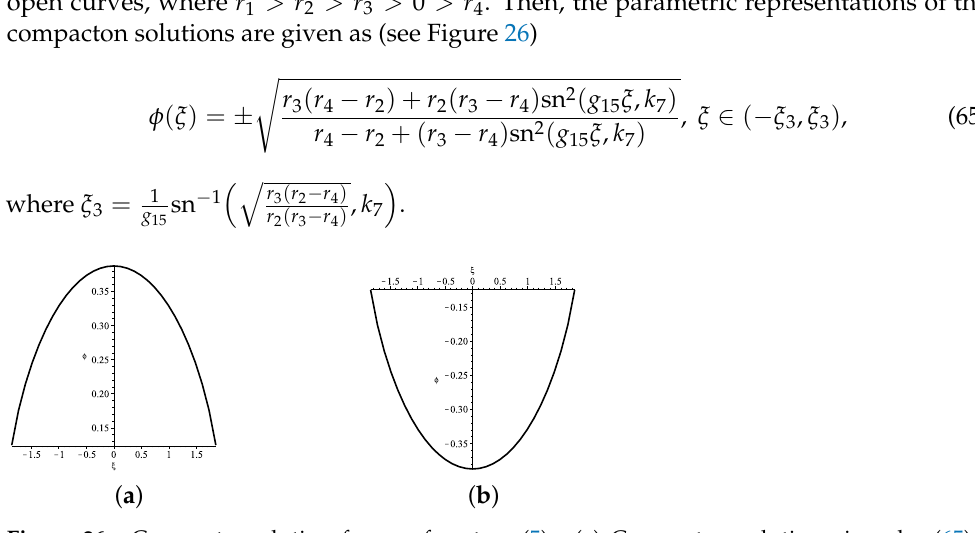
Figure 26. Compactonsolution forms of system (5). ( a ) Compacton solution given by (65) + . ( b ) Compacton solution given by (65) −